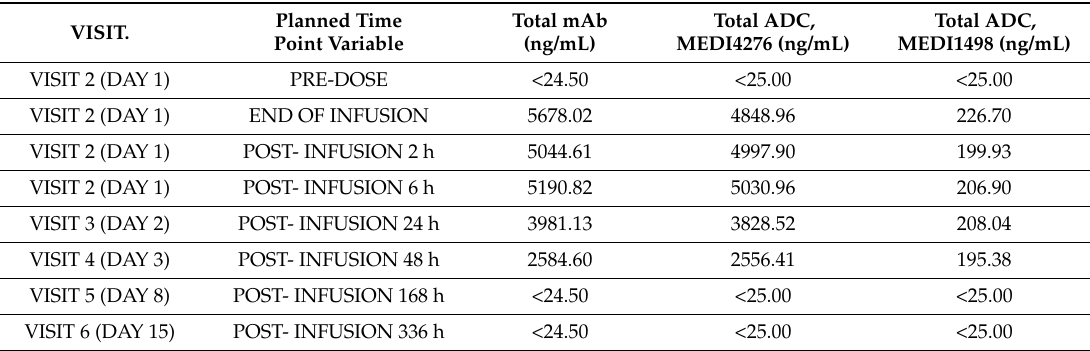
Table 8. Representative pharmacokinetic (PK) data. Data for total mAb, total ADC from MEDI4276 and MEDI1498 from a representative subject (ID# 20016190001).